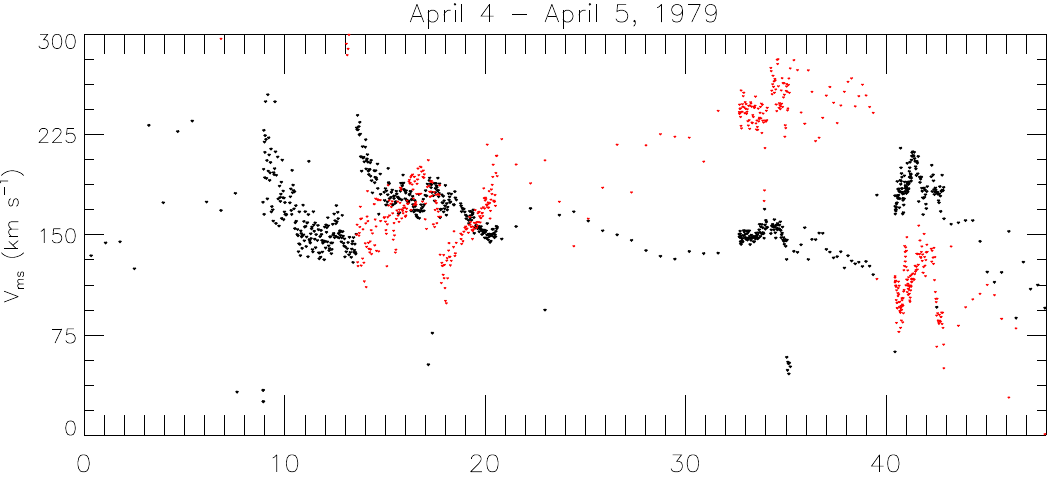
Fig. 5. The local magnetosonic speed on 4–5 April 1979 (black symbols) and the local speed of the shock S3 relative to the ejecta E2 (red